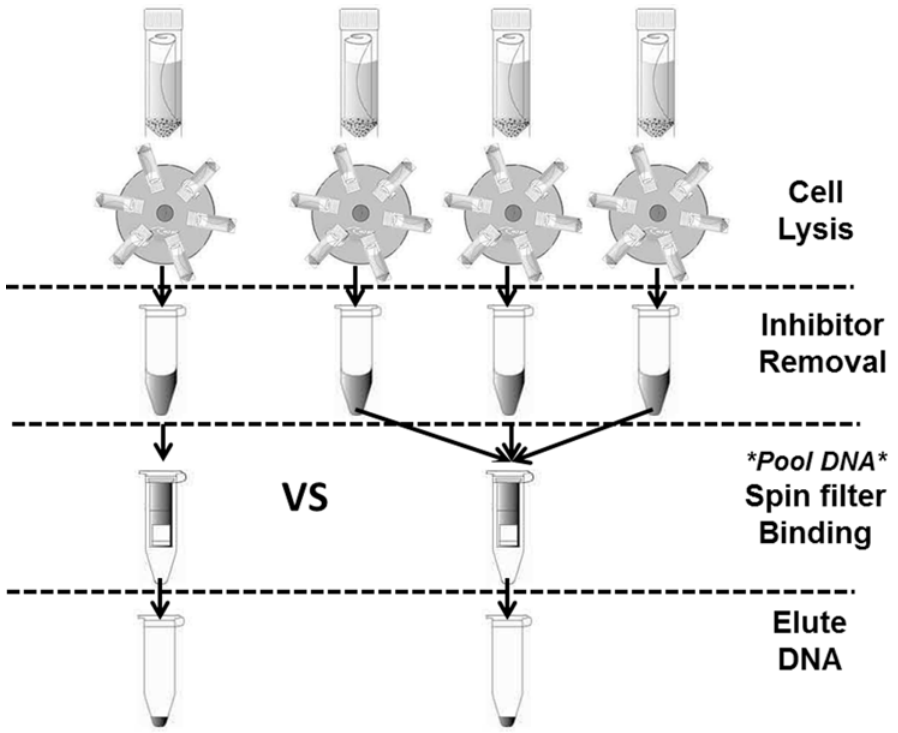
Fig 2. Concentration approach during extraction. The DNA from three filters is pooled during the spin- filter binding step of DNA extraction. The total DNA yield is then compared to the one filter extracted alone to investigate whether the expected 3-to-1 ratio is